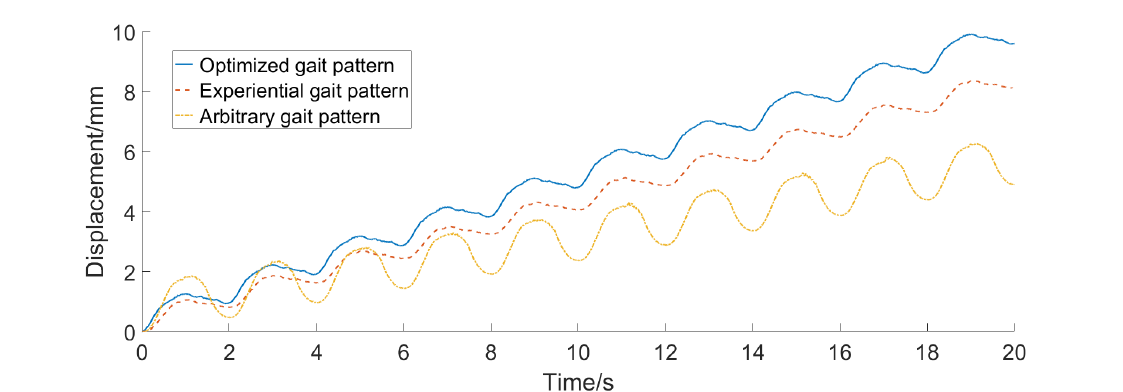
Figure 8. Displacement curves of different gait patterns of worm